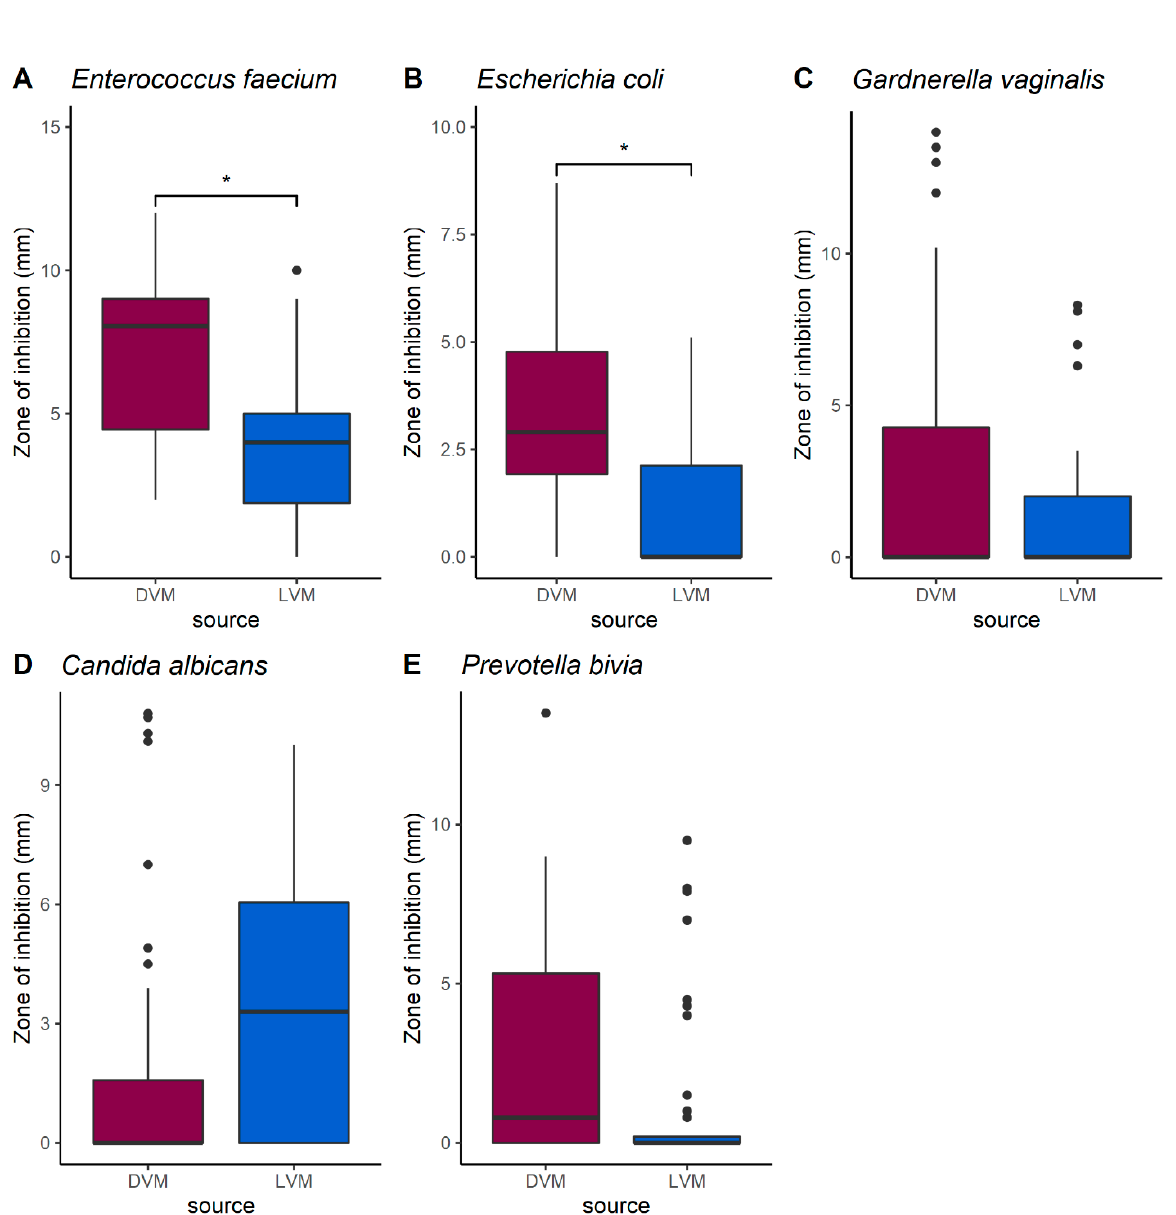
Figure 6. Differences between the antimicrobial capacity of L. crispatus strains isolated from dysbiotic and Lactobacillus dominated vaginal environments. Against ( A ) Enterococcus faecium , ( B ) Escherichia coli , ( C ) Gardnerella vaginalis , ( D ) Candida albicans , and ( E ) Prevotella bivia. Burgundy represents strains isolated from dysbiotic vaginal microbiota (DVM; n = 8) and blue represents strains isolated from Lactobacillus dominated vaginal microbiota (LVM; n = 11). A linear mixed effects model to control for individual strain effects was used to evaluate differences between the groups (* p < 0.05).